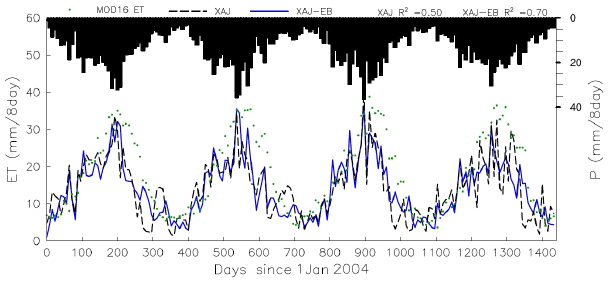
Figure 9. Comparison among MODIS-retrieved, XAJ and XAJ- EB-modeled 8-day catchment-average evapotranspiration (ET) for period between 1 January 2004–31 December 2007. The 8-day gauge-measured catchment-average precipitation is also shown for the same